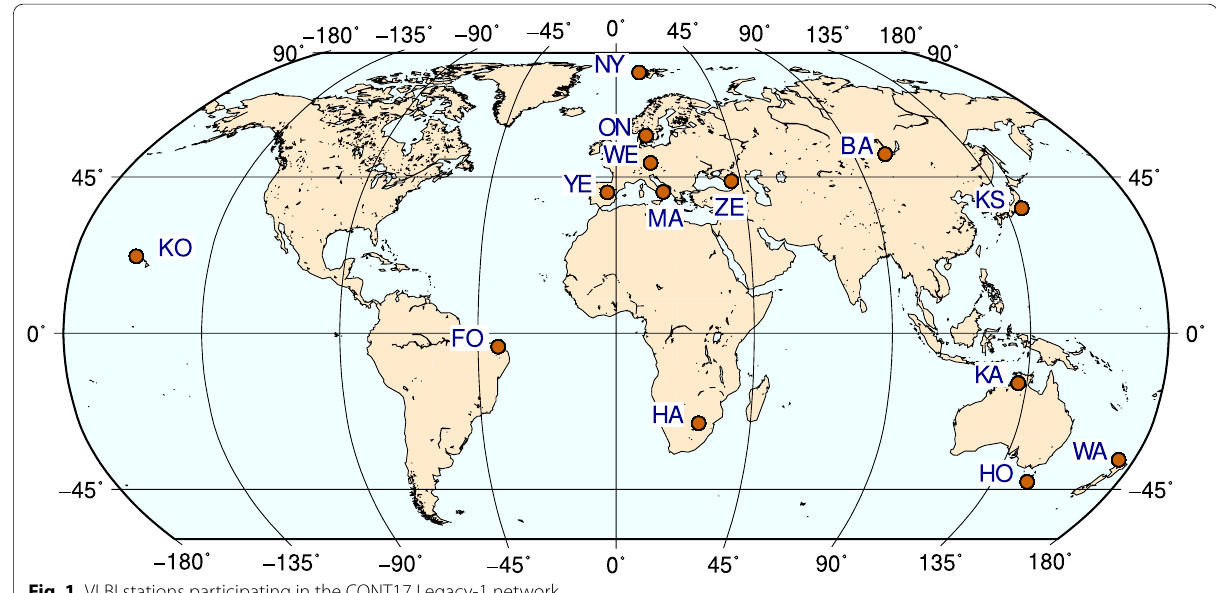
Fig. 1 VLBI stations participating in the CONT17 Legacy‑1 network